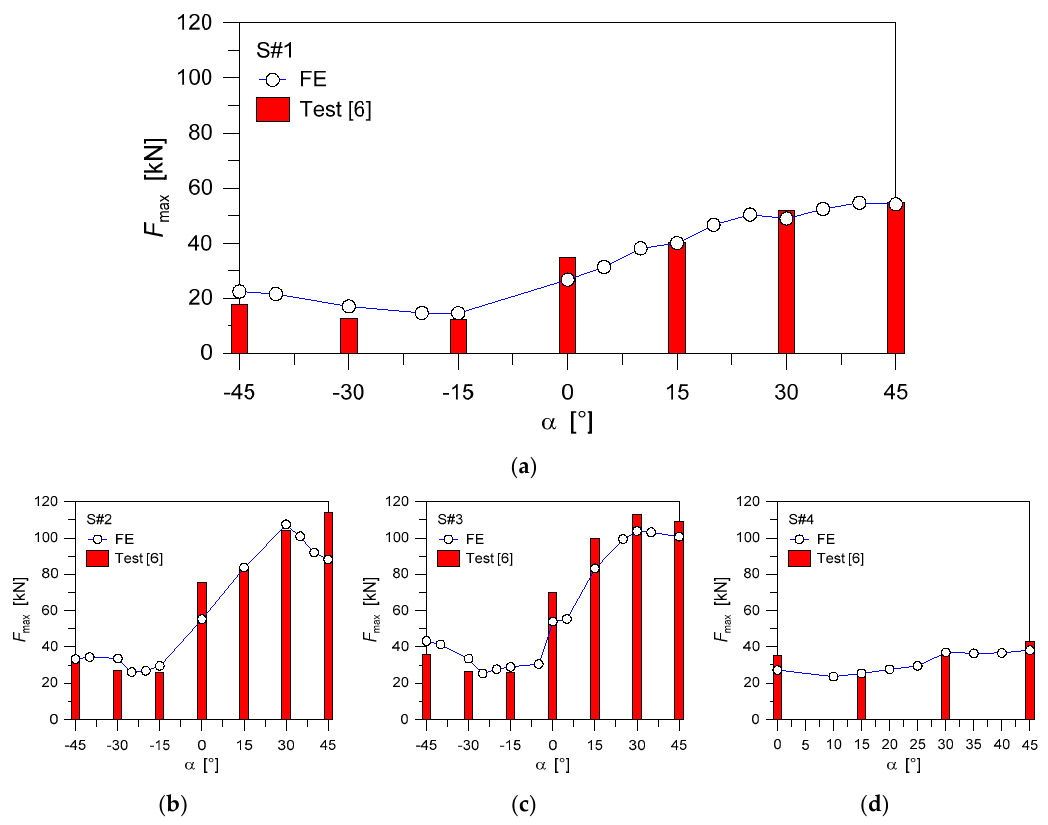
Figure 10. Comparison of numerical (ABAQUS/Explicit) and experimental [6] maximum force estimates for TTC joints with inclined STSs: ( a ) S#1, ( b ) S#2, ( c ) S#3 and ( d ) S#4 joints.